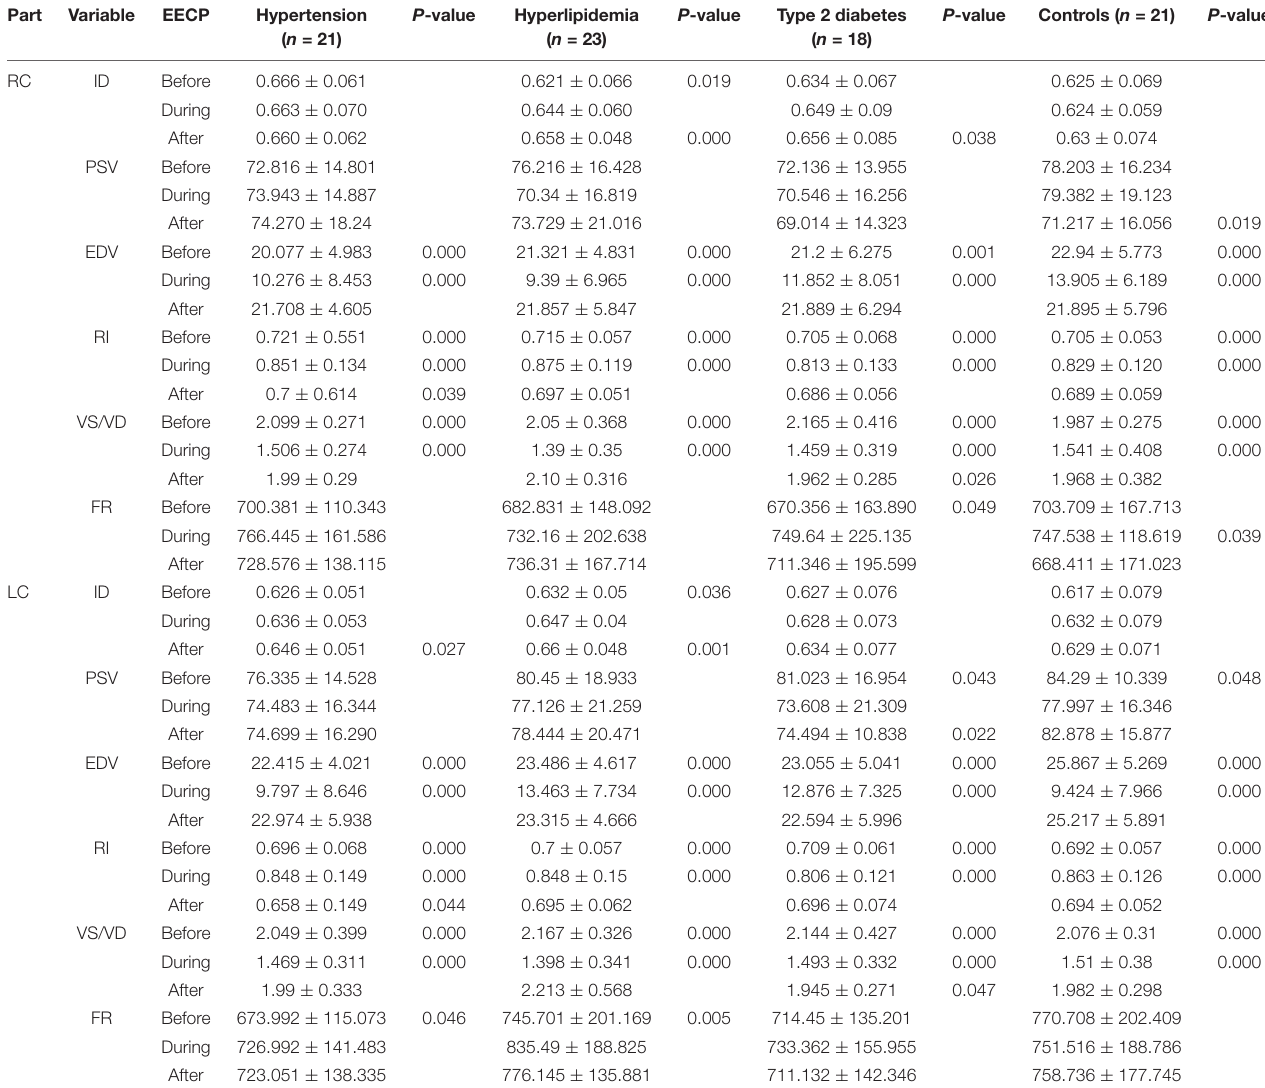
TABLE 2 | Hemodynamic variables in the CCAs before, during and immediately after EECP in each group.